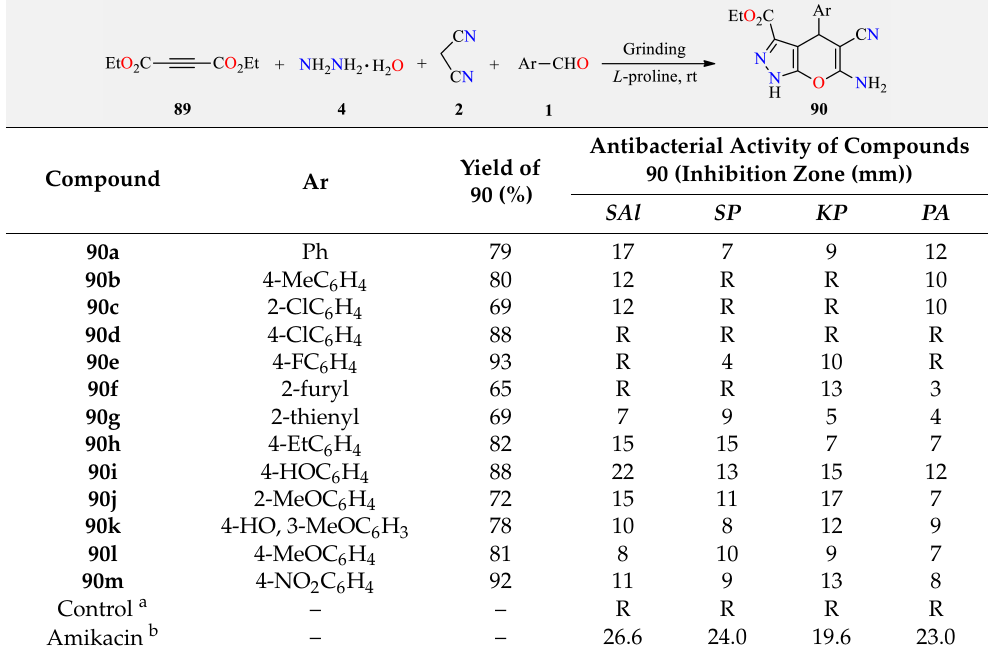
Table 24. Four-component synthesis of dihydropyrano[2,3- c ]pyrazole 90 and their in vitro antibacte- rial activity against four bacterial strains.